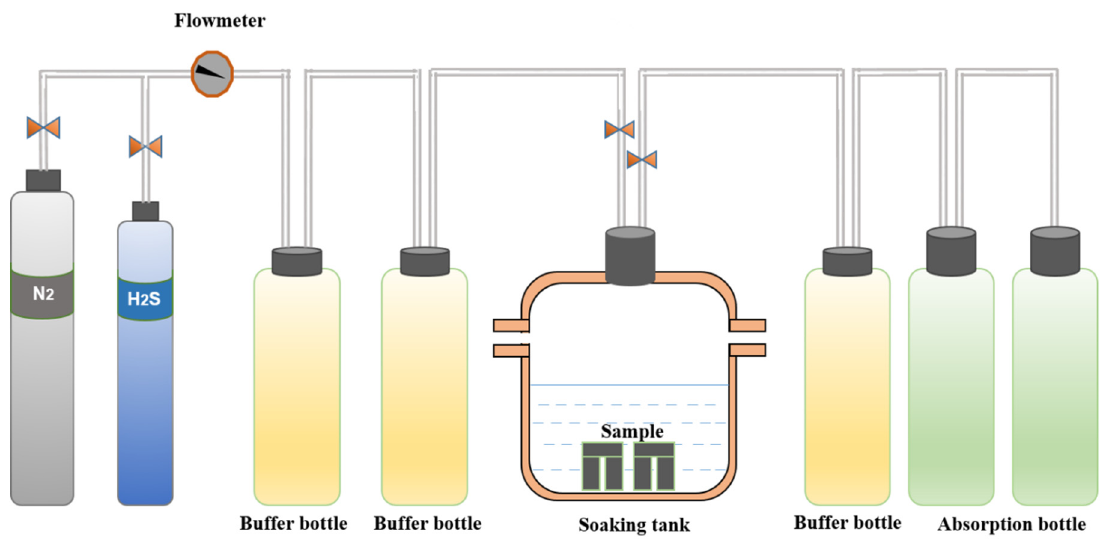
Figure 2. Schematic diagram of the experimental set-up (DCB).